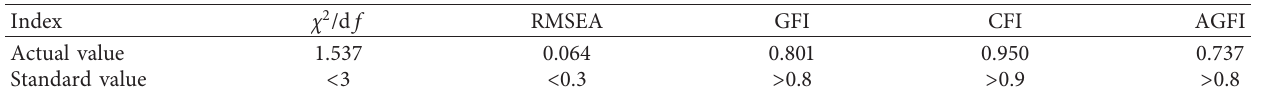
Table 4: Test results of goodness of